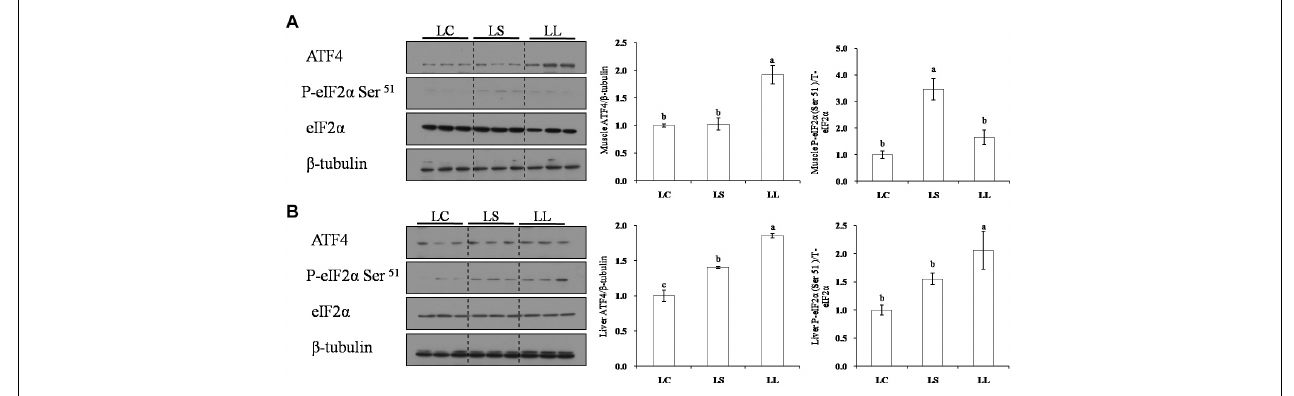
FIGURE 5 | Effects of the LC diet, LL diet supplemented with dietary lysine (LS diet) and the LL diet on muscle (A) and liver (B) protein phosphorylation levels of key regulators involved in AAR signaling pathway. Different superscript letters “a, b” indicated statistical significant differences ( P < 0 . 05; mean ± SEM, n =